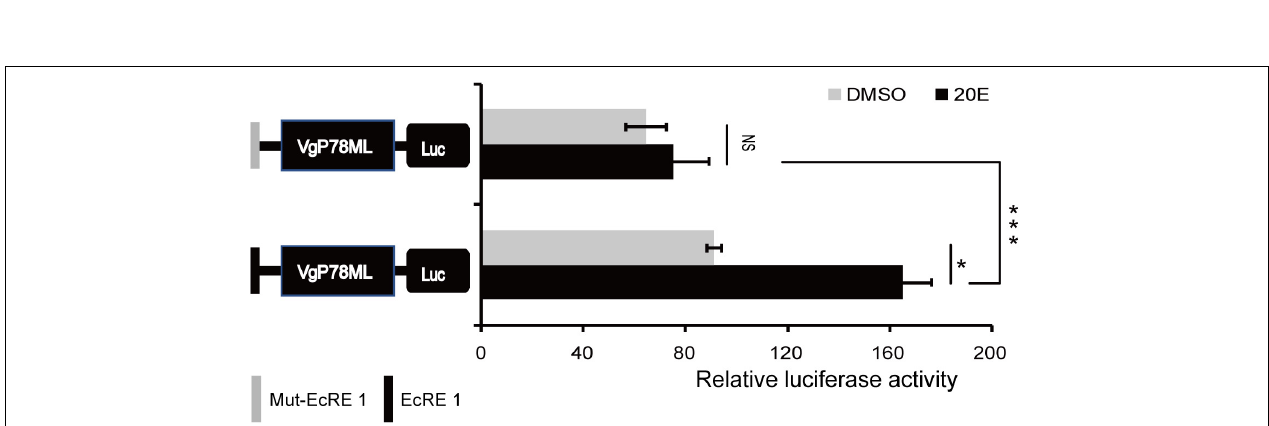
FIGURE 5 | Effect of 10 nM 20-hydroxyecdysone (20E) on the EcRE-1. Luciferase activity of the basic promoters containing EcRE-1 and mut-EcRE 1 after treatment with 10 nM 20E and DMSO, respectively. Mut, mutated, NS, not significant. * P < 0.05, *** P < 0.001; t -test.